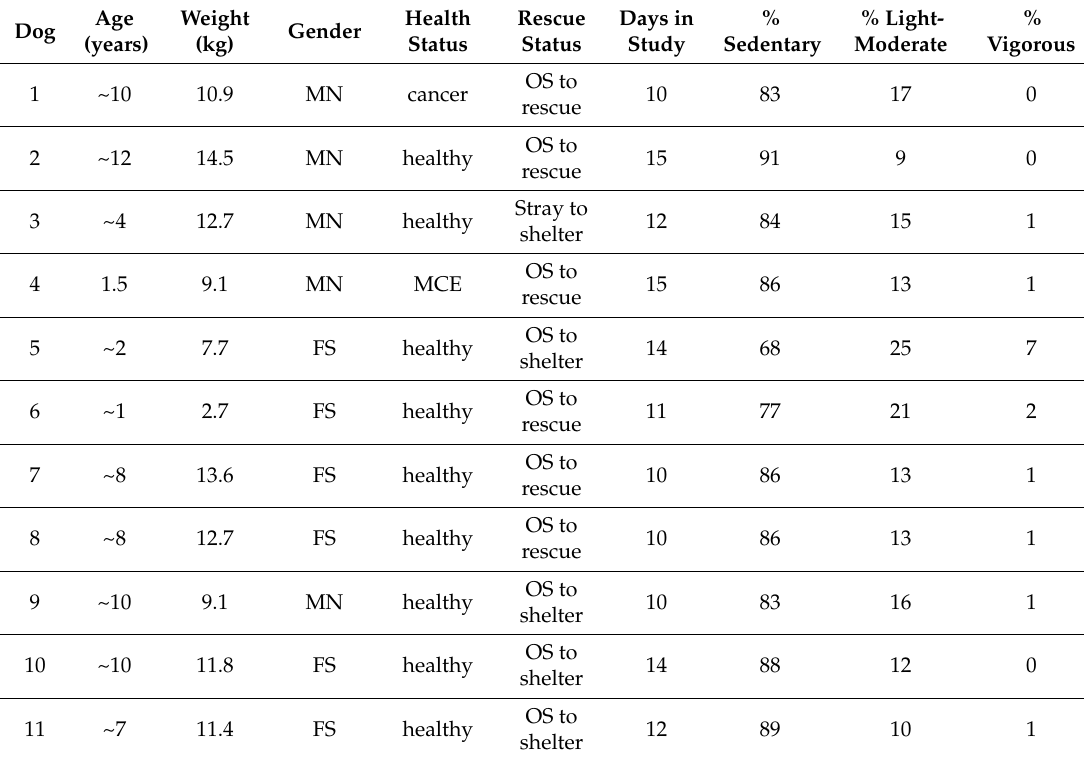
Table 1. Dog characteristics including average sedentary behavior, light-moderate activity, and vigorous activity bout